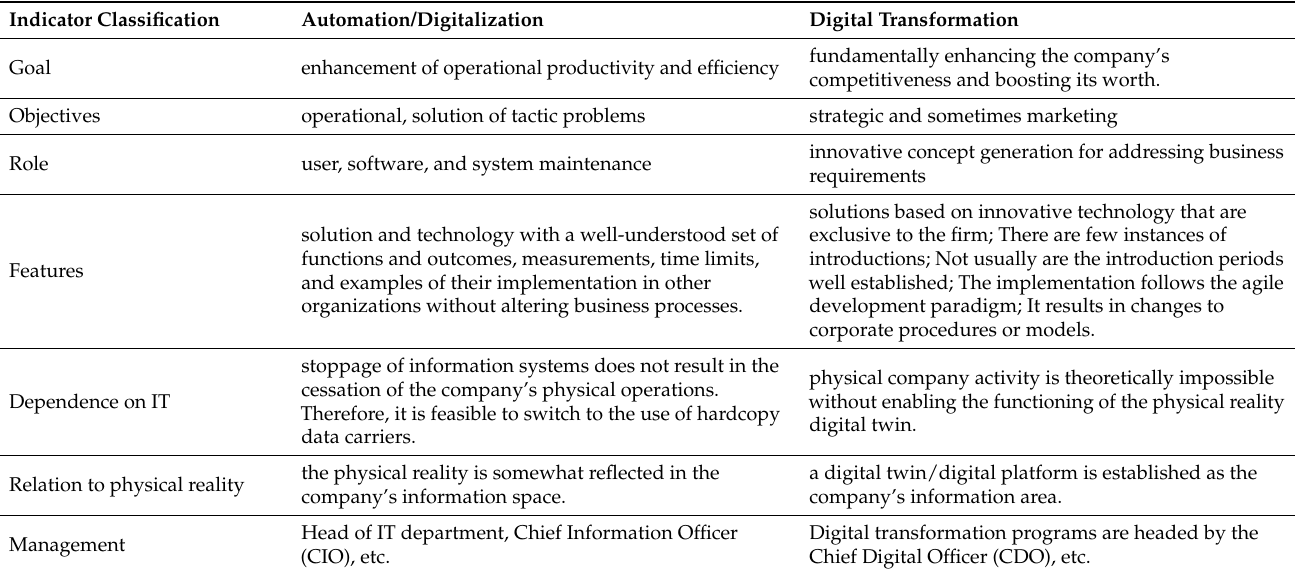
Table 1. Key indicators characterizing the notion “digitalization” and “digital transformation”